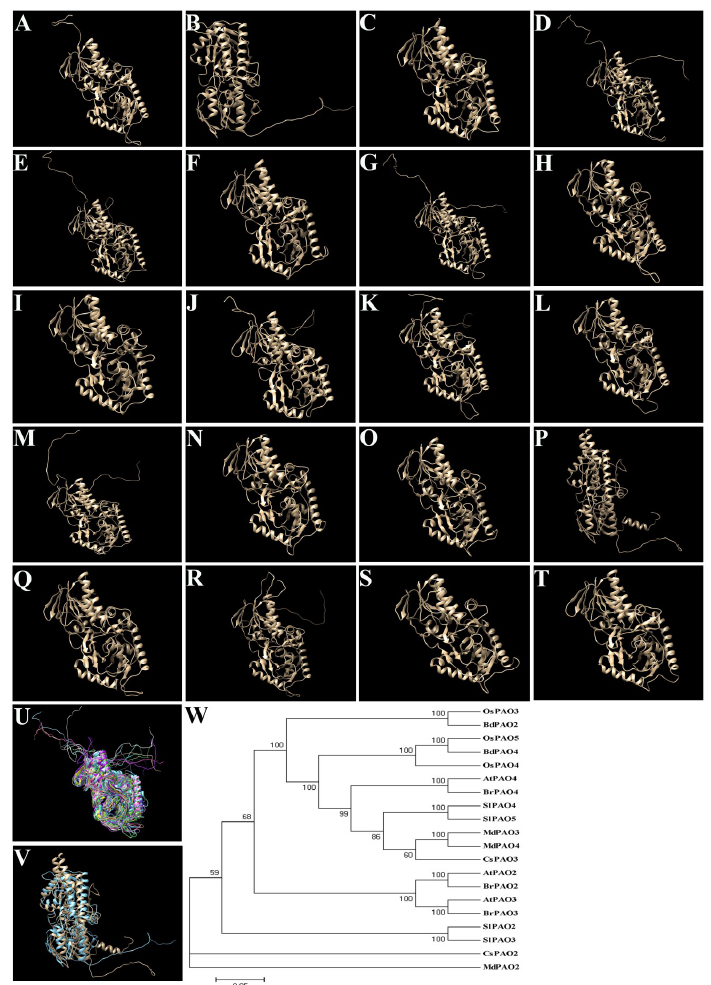
Figure 4. Predicted tertiary structures of the reported peroxisomal PAOs. Twenty have been reported; peroxisomal plant PAOs were analyzed. ( A – J ), The protein 3-D structures of OsPAO3 ( A ); OsPAO4 ( B ); OsPAO5 ( C ); AtPAO2 ( D ); AtPAO3 ( E ); AtPAO5 ( F ); SlPAO2 ( G ); SlPAO3 ( H ); SlPAO4 ( I ); SlPAO5 ( J ); BdPAO2 ( K ); BdPAO4 ( L ); BrPAO2 ( M ); BrPAO3 ( N ); BrPAO4 ( O ); CsPAO2 ( P ); CsPAO3 ( Q ); MdPAO2 ( R ); MdPAO3 ( S ); and MdPAO4 ( T ) were obtained using the Protein Structure Prediction Server program (http: // ps2v3.life.nctu.edu.tw / ) and Chimera 1.13 software. ( U ) Merged image of all PAOs, except OsPAO4 and CsPAO2, was performed by Chimera 1.13 software. ( V ) Merged image of OsPAO4 and CsPAO2 was similarly performed. The light blue and light yellow colors indicate the protein structures of OsPAO4 and CsPAO2, respectively. ( W ) Evolution relationship among the peroxisomal